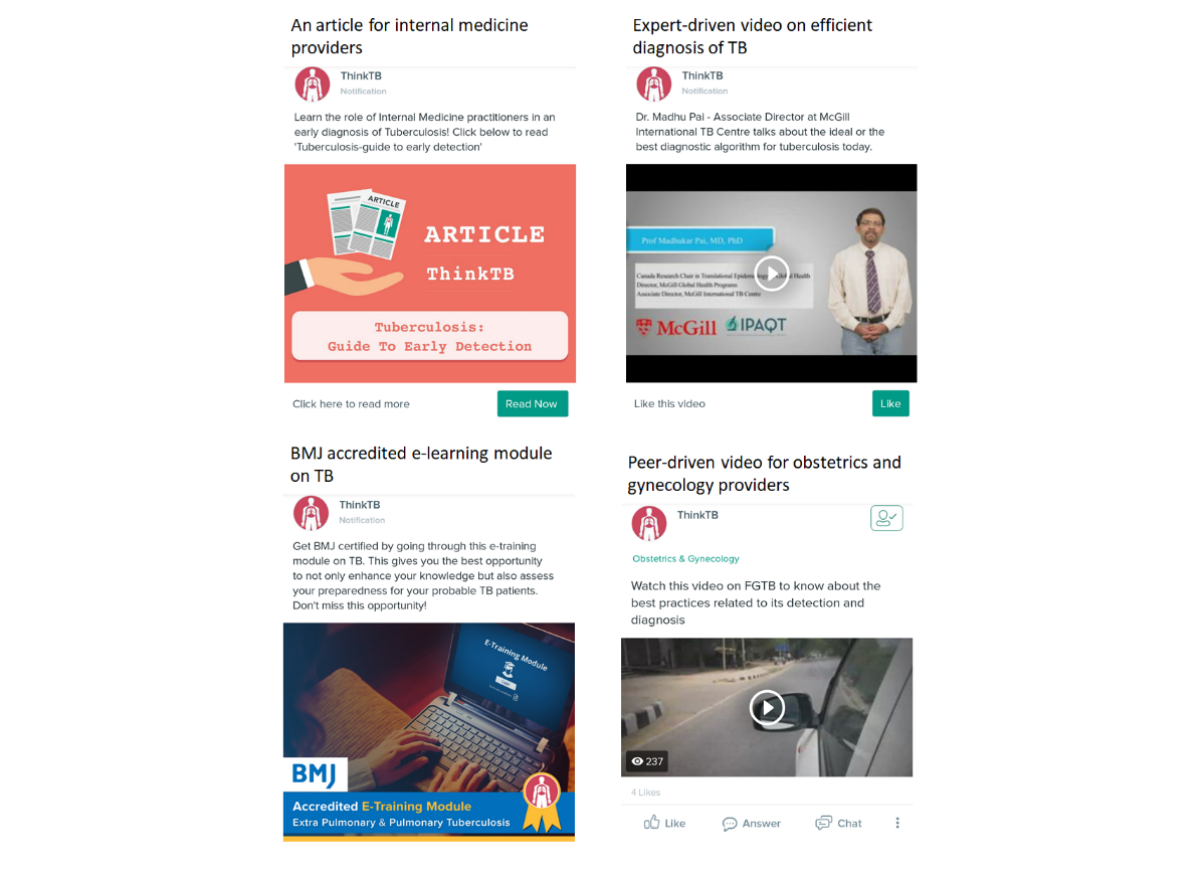
Figure 1. Mobile screenshots of content pieces from the ThinkTB